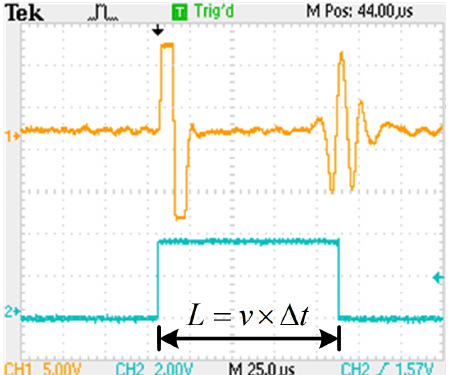
Figure 2. Oscilloscope waveform of induction signal.